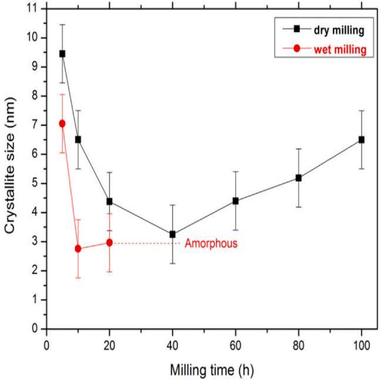
The mean crystallite size evolution during wet and dry ball milling.